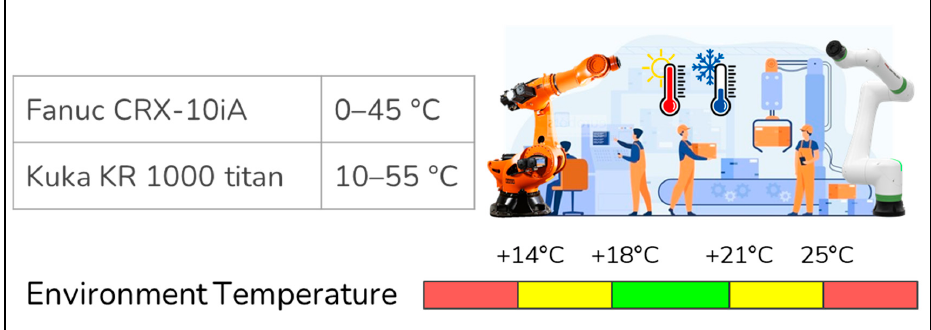
Figure 6. The visual representation of the optimum temperature ranges within the product line environment.